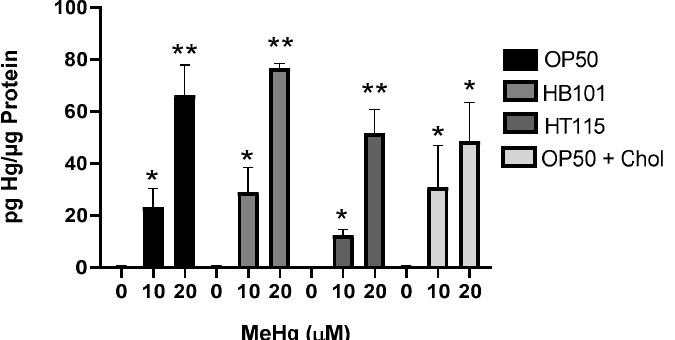
Figure 2. Bacterial diet does not affect MeHg content in worms. Hg content was measured by ICP- MS in worms fed OP50, HT115, HB101, or OP50+ cholesterol diets 48 h after MeHg treatment. Hg levels are expressed as pg Hg/µg protein. Data represent four independent experiments. * p < 0.05, ** p < 0.01 as compared to untreated, OP50-fed control.